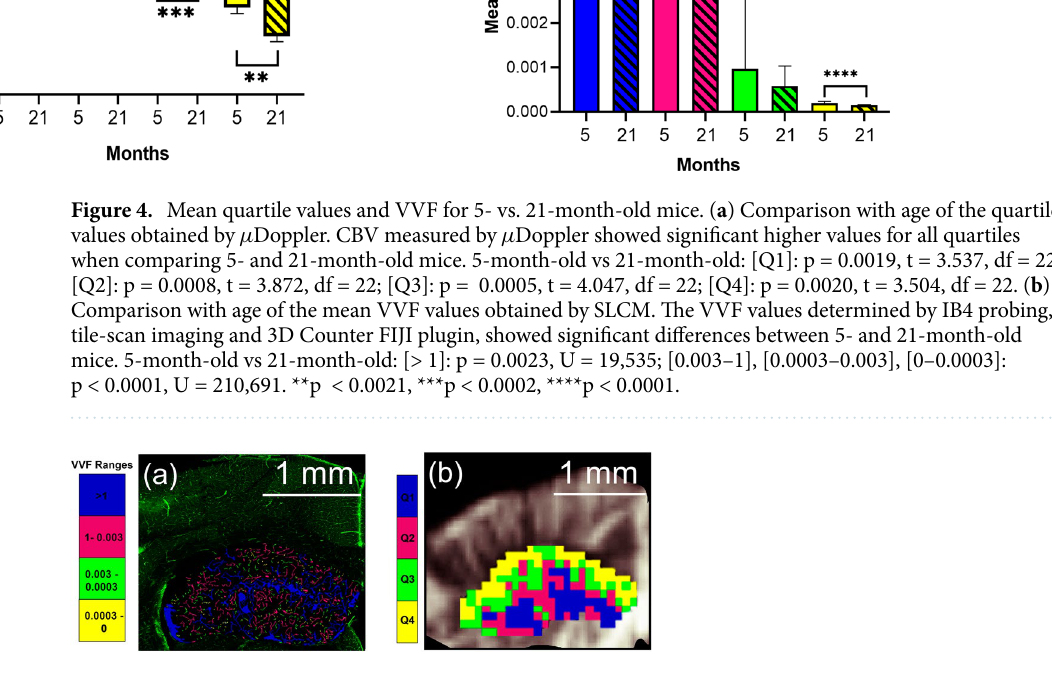
Figure 5. CBV and vascular structure. ( a ) A tile-scan image of the hippocampal endothelial vascular IB4 signal obtained by SLCM (green image) is overlapped with the 3D counter object image showing the identified ranges of volume distribution. Vessels in the 0–0.0003, 0.0003–0.003, 0.003–1 and > 1 range were coloured yellow, green, fuchsia and blue, respectively. ( b ) µ Doppler image overlaid with segmented hippocampus with CBV quartile distribution. Blue, fuchsia, green and yellow corresponds to quartiles Q1, Q2, Q3 and Q4,